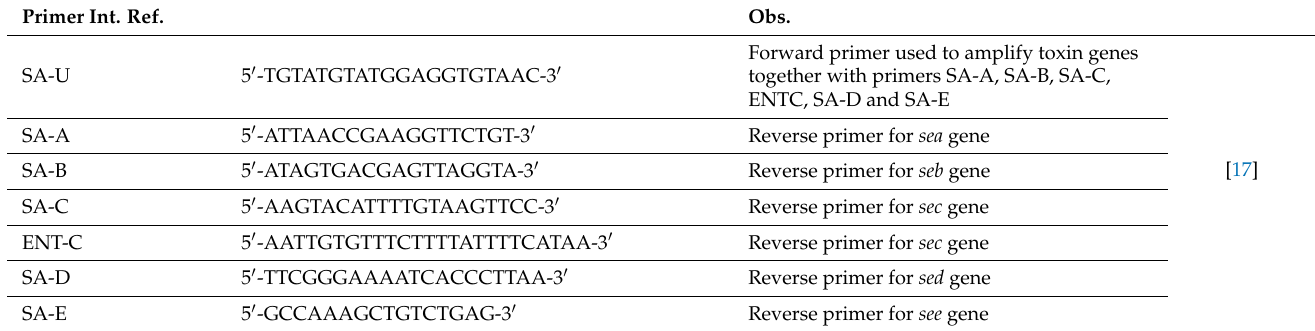
Table 1. Primers used for the detection of toxin, virulence and antibiotic resistance genes. Primer Int.